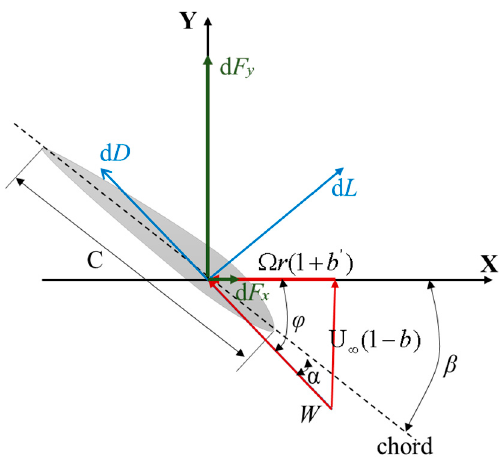
Figure 2. The velocity component diagram and force diagram of blade element.